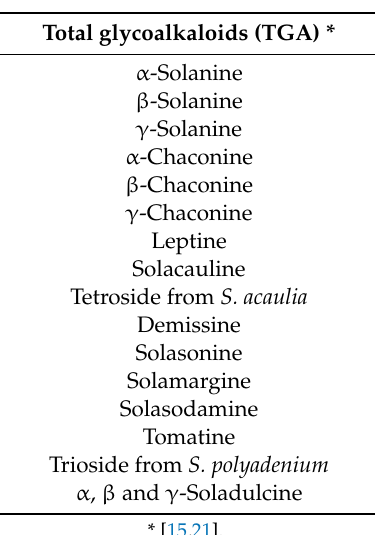
Table 1. Solanum